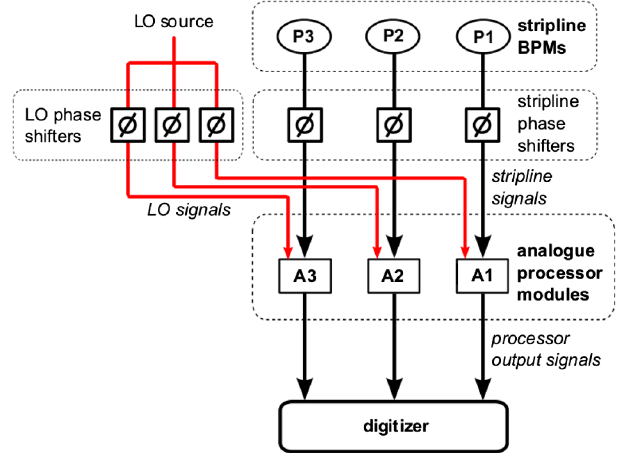
FIG. 3. Schematic of the FONT5 BPM system. For each BPM, a phase shifter is used on one of the stripline signals to adjust the relative path lengths of the two input signals at the BPM processor, and another phase shifter is used to adjust the phase of the LO signal at each processor (see Sec.